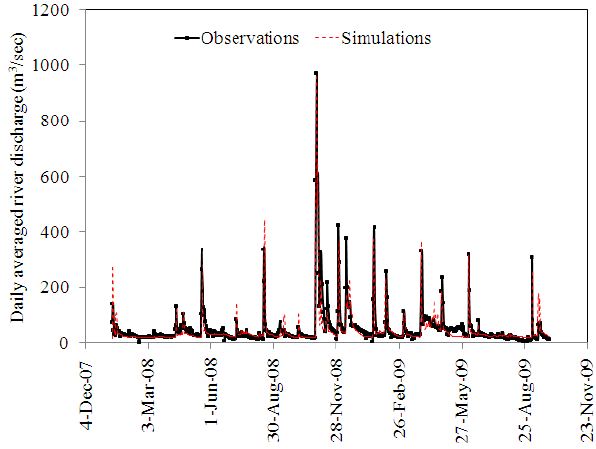
Fig. 5 Observed and simulated daily averaged river discharge at the Venzone station Fig. 5. Observed and simulated daily averaged river discharge at the Venzone